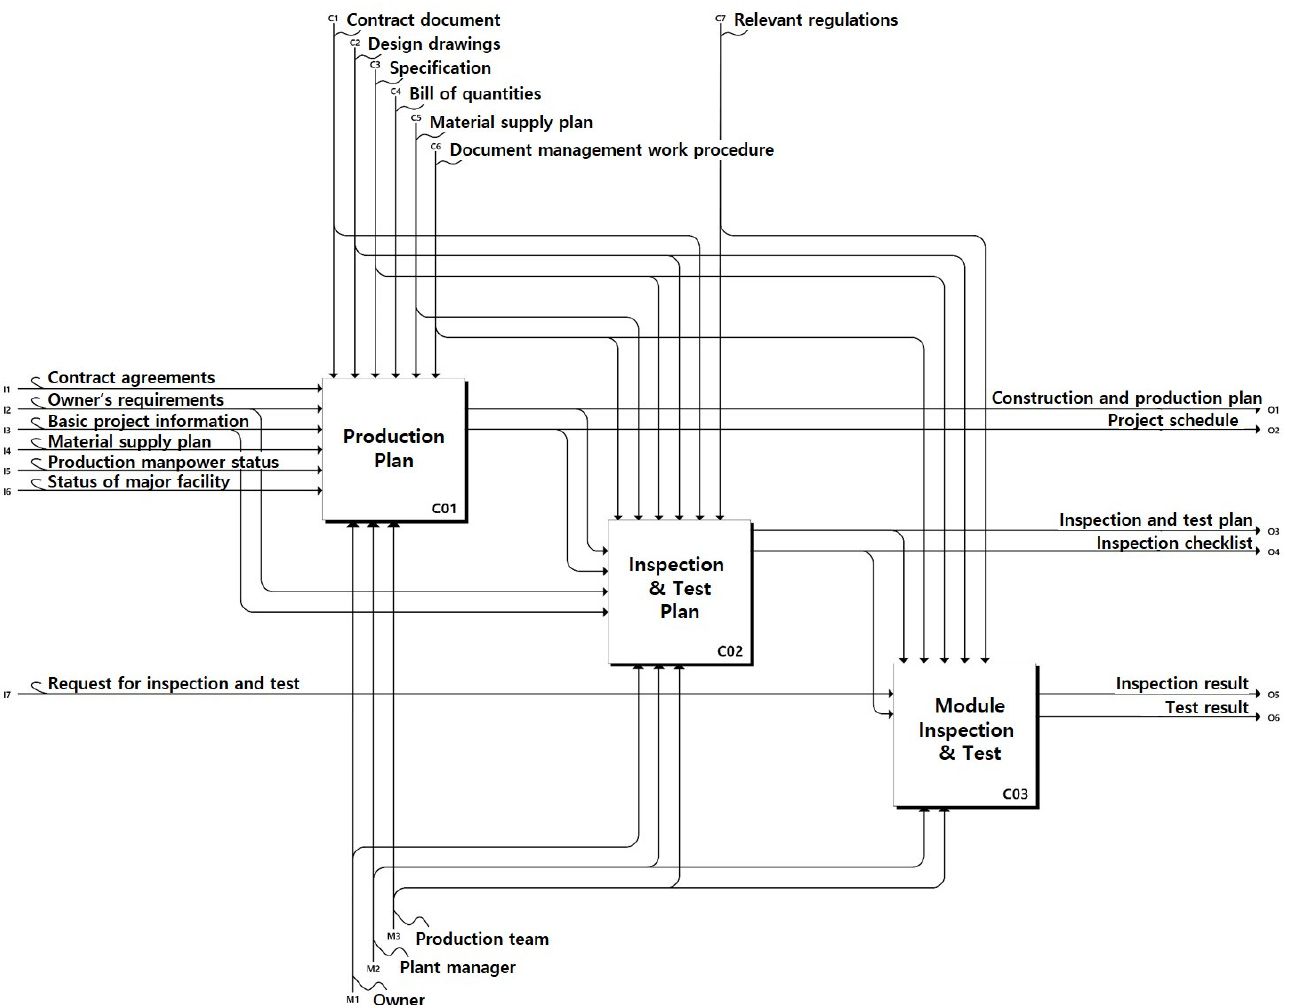
Figure 5. IDEF0 modeling results for quality management in